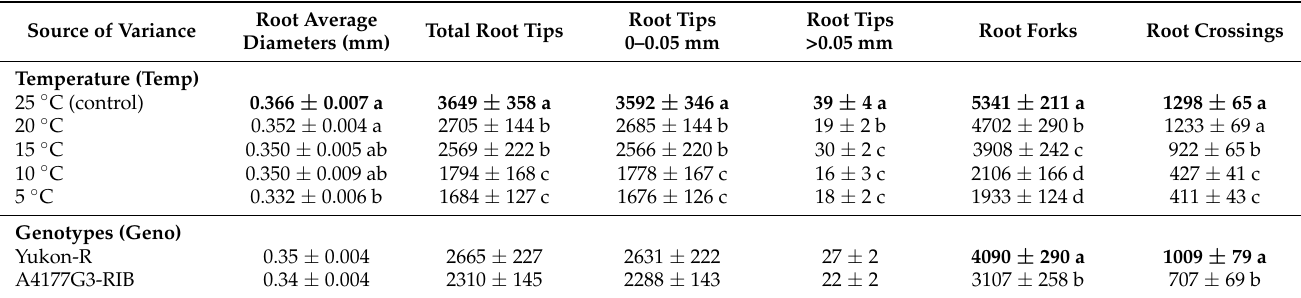
Table 3. Analysis of variance and mean comparisons for root average diameters, total root tips, root forks, and root crossings of silage corn genotypes grown at different temperatures under a controlled